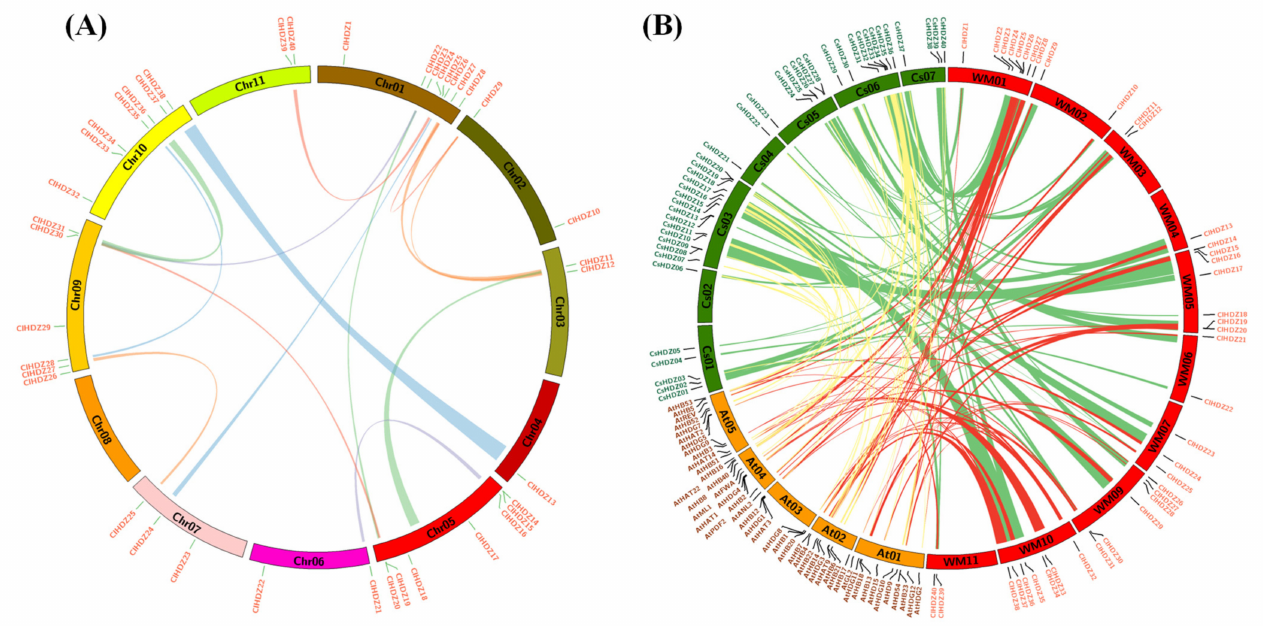
Figure 3. Syntenic analysis of the HD-ZIP genes in watermelon ( A ) as well as among three genomes ( B ), i.e., watermelon (red), cucumber (green), and Arabidopsis (Orange). The approximate position of the HD-ZIP genes on the chromosome were presented by short lines on the circle. Colored curves denote the details of the syntenic region harboring the HD-ZIP genes among the